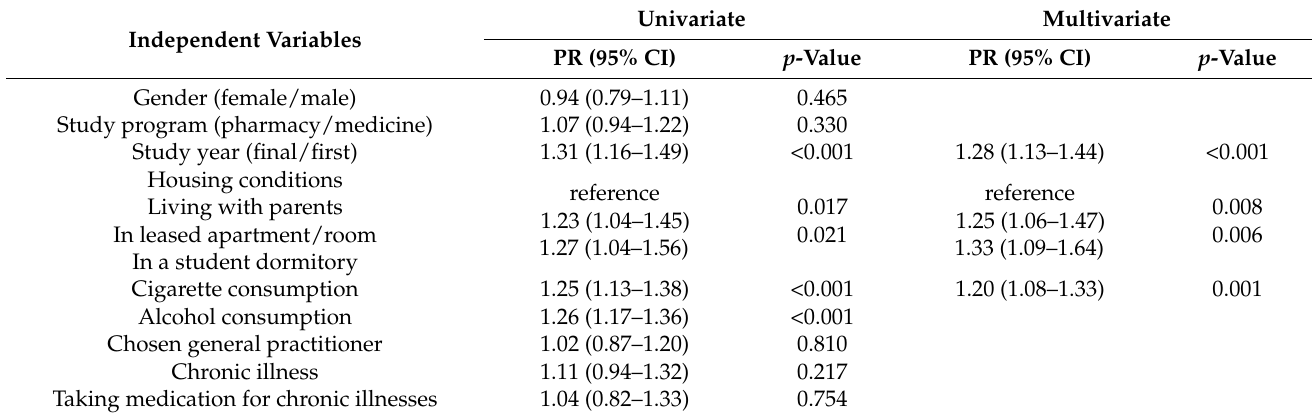
Table 5. Poisson regression model with robust variance using self-medication as a dependent